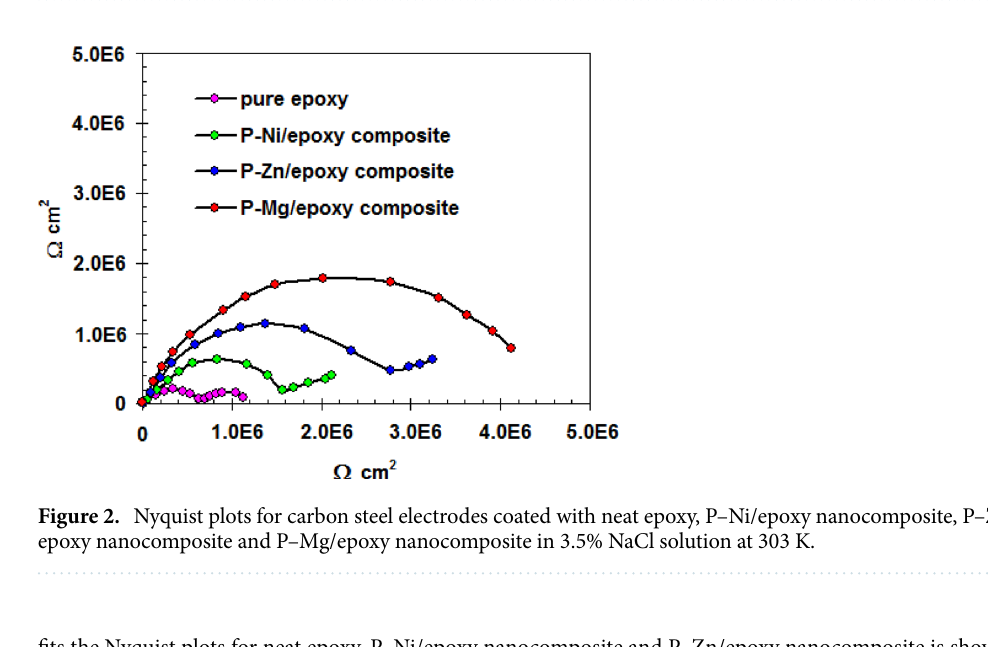
Figure 1. XRD pattern of M 0.5 VOPO 4 (where M = Mg ( a ), Ni ( b ) and Zn ( c )).